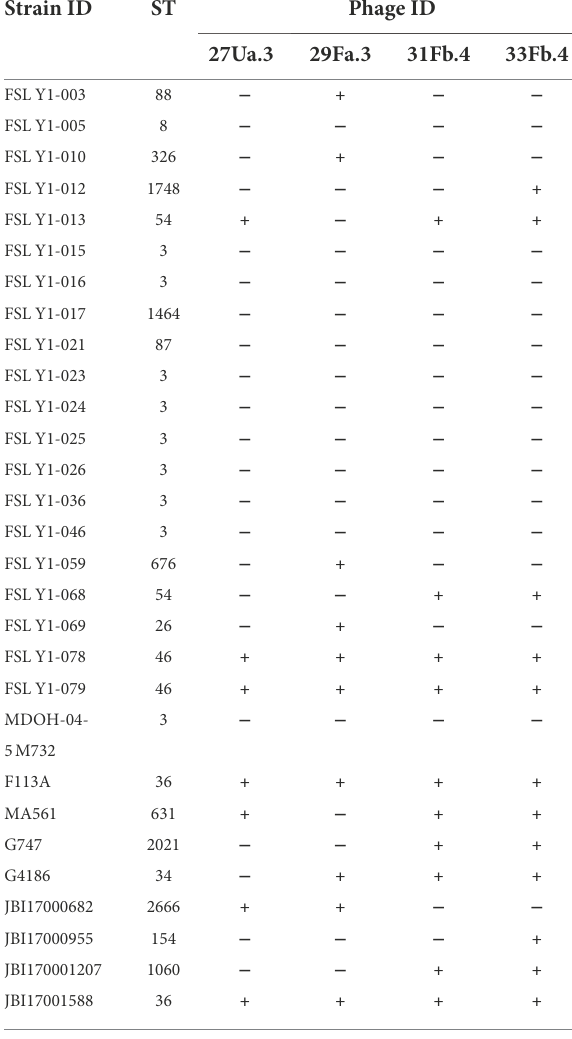
TABLE 2 Susceptibility patterns of four unique